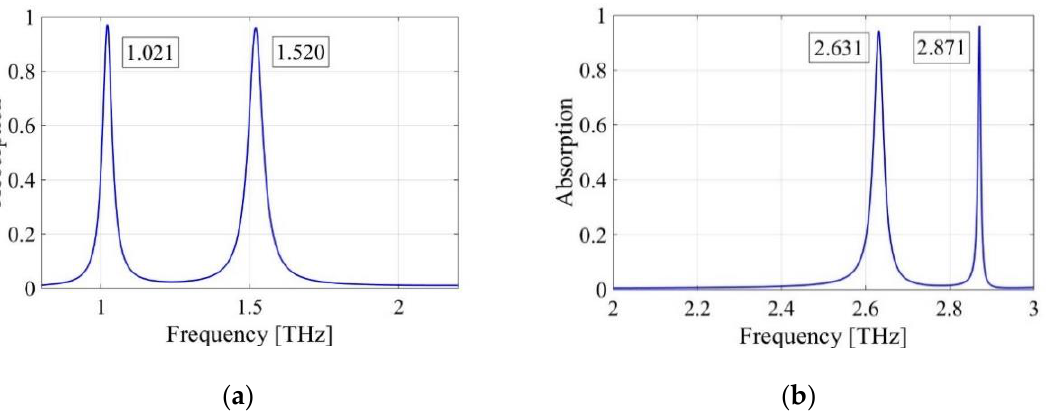
Figure 4. Absorption response of ( a ) SquarePMA and ( b ) CrossPMA with resonant frequencies in THz.